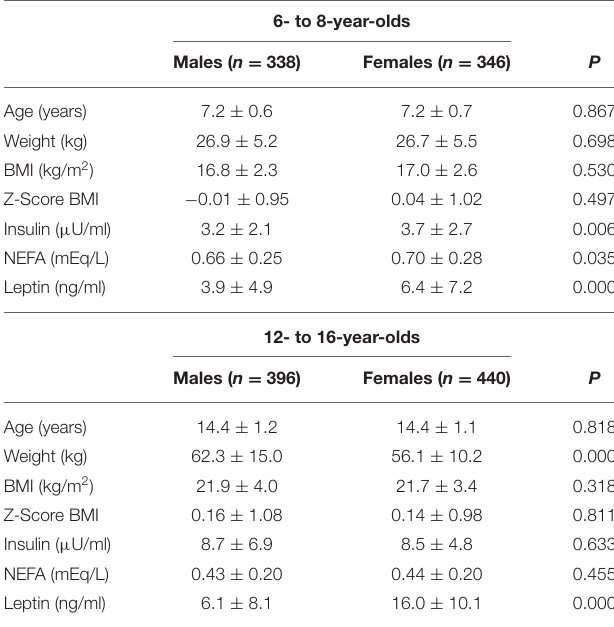
TABLE 1 | Anthropometric and biochemical characteristics (mean ± SD) of males and females by